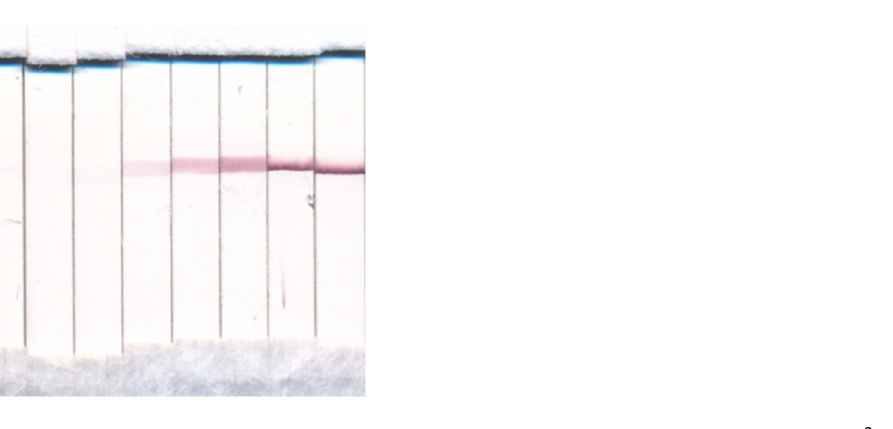
Figure 10. Photo images of test strips after application of water sample containing Hg 2+ in the following concentrations: 0, 0.1, 1, 2.5, 5, 10, 25, and 50 ng/mL (left to right). Table 2. Determination of Hg 2+ in water samples using the developed method.